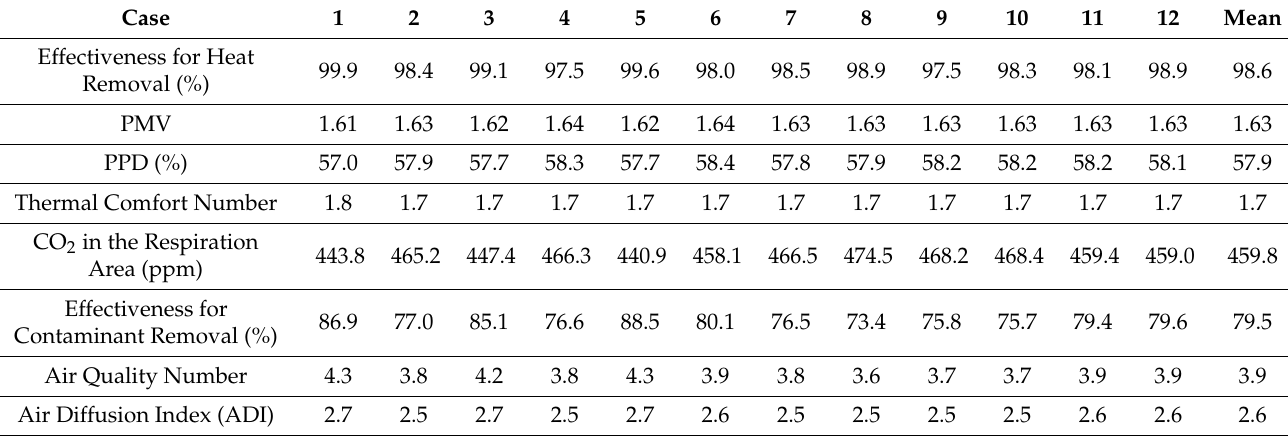
Table 5. ADI obtained for Case I (0.0778 m 3 /s) at 10